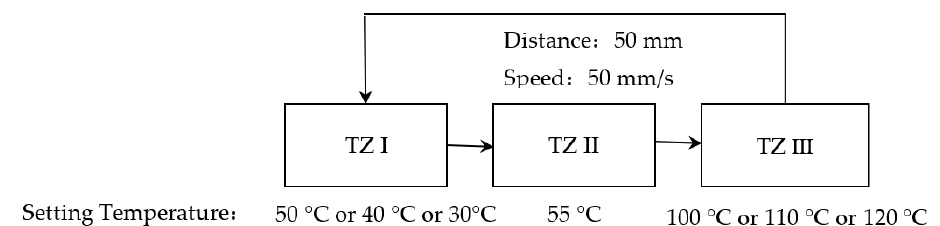
Figure 7. Different physical configurations to study the effect of different temperature overshoots on the ramp rates of the solution.